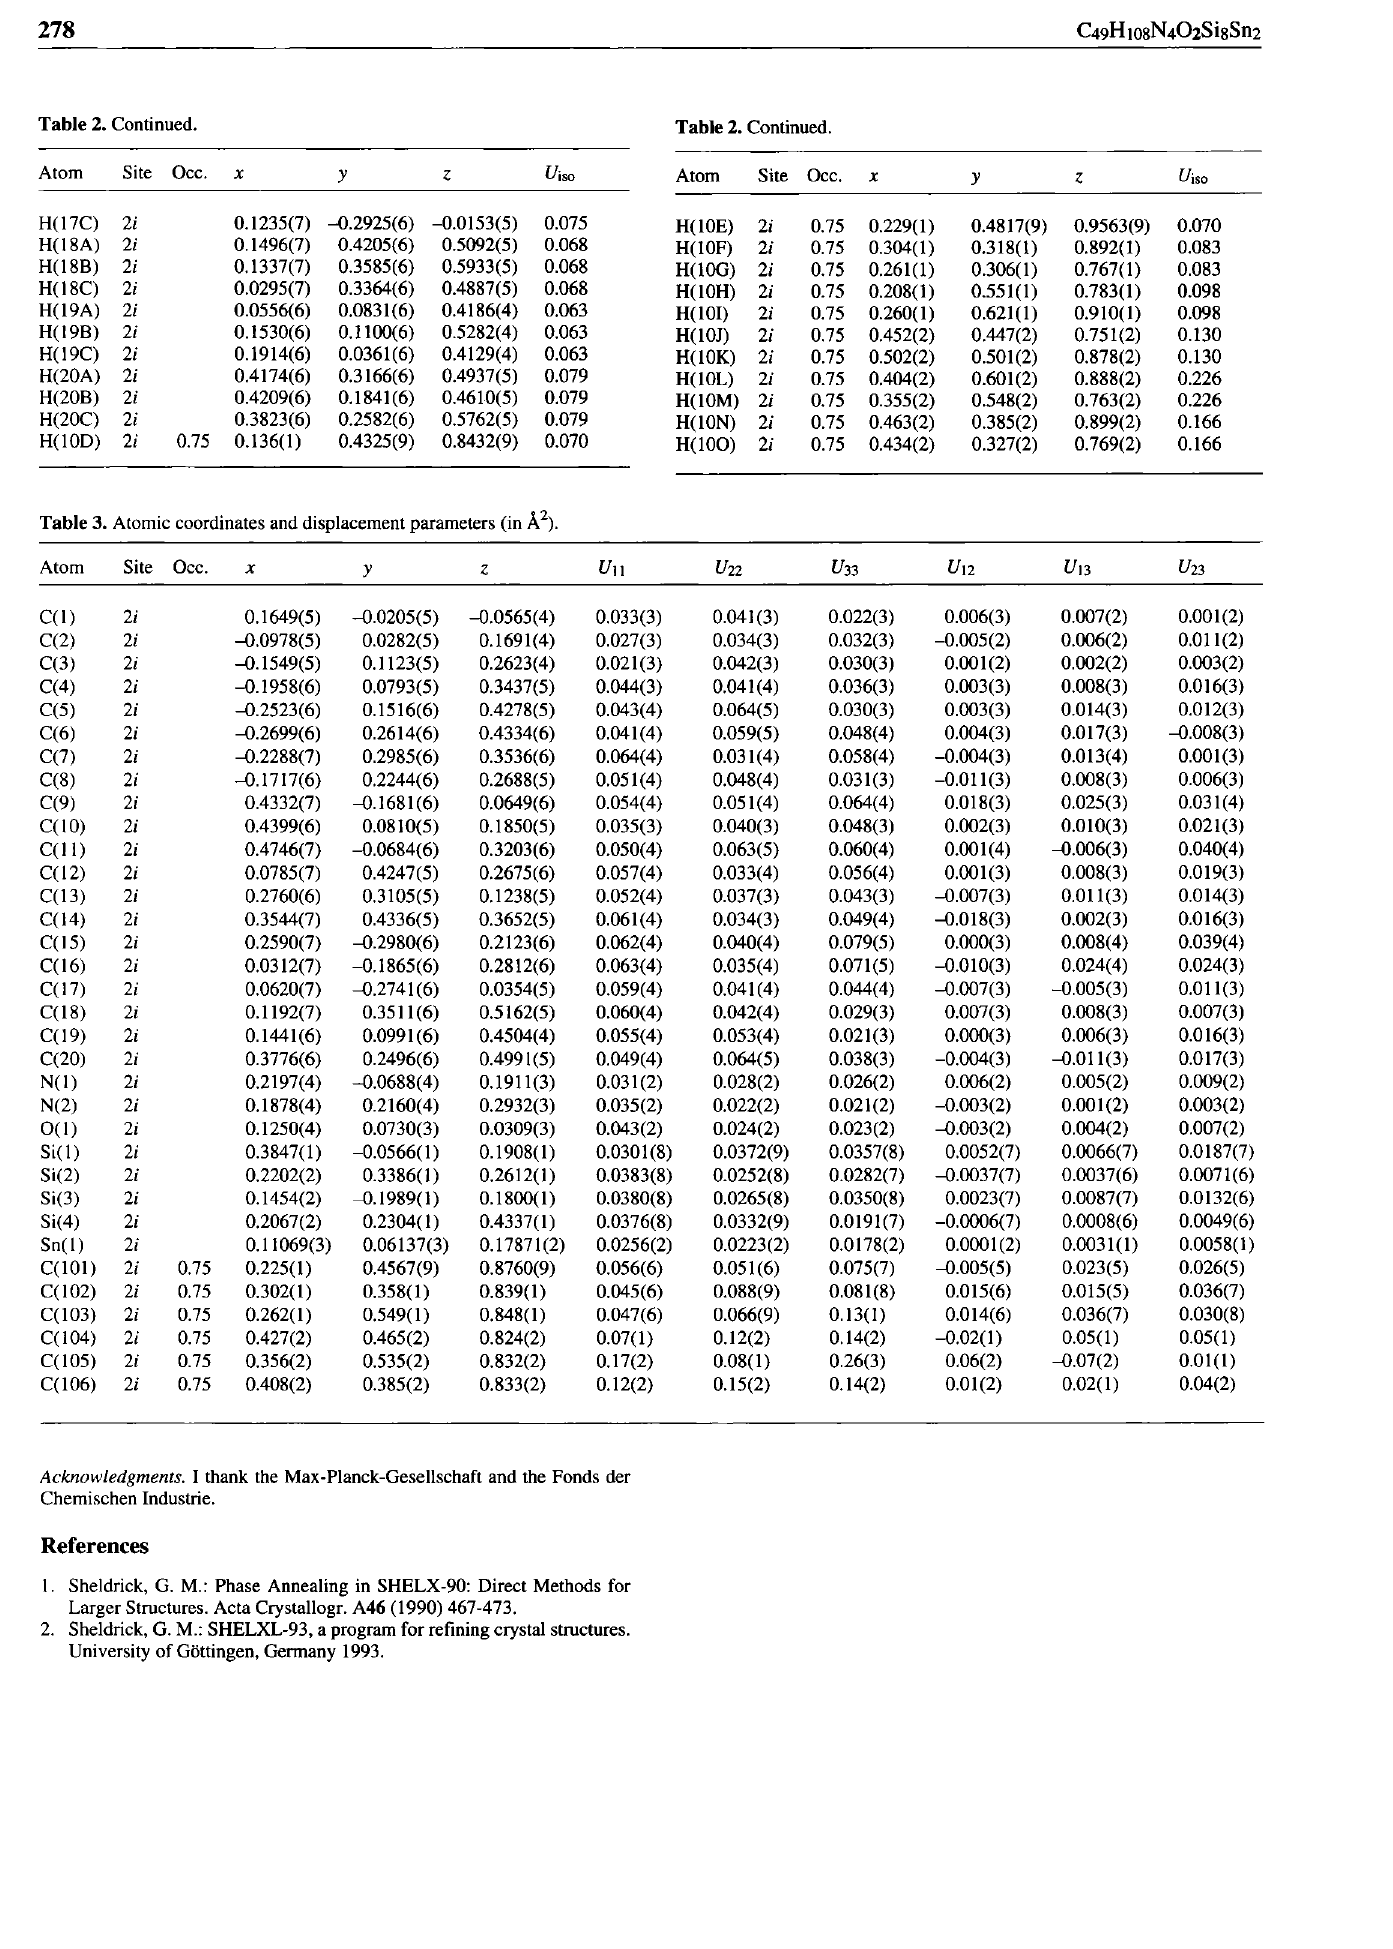
Table 3. Atomic coordinates and displacement parameters (in Ä 2